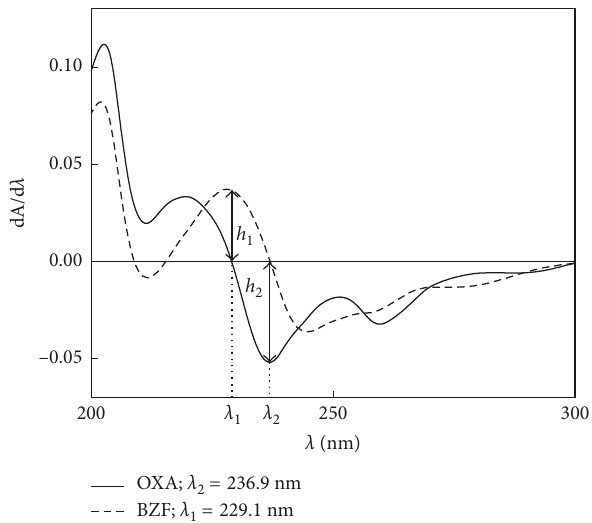
Figure 2: OXA and BZF first-order absorption derivative spectra.